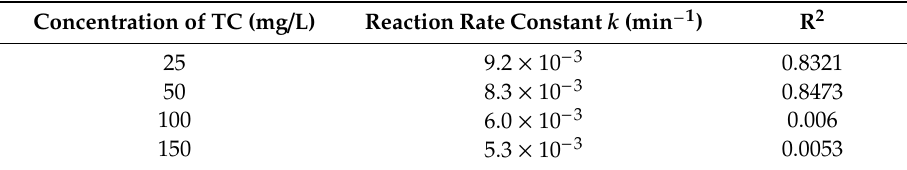
Table 3. The reaction rate of tetracycline degradation at di ff erent initial concentrations.